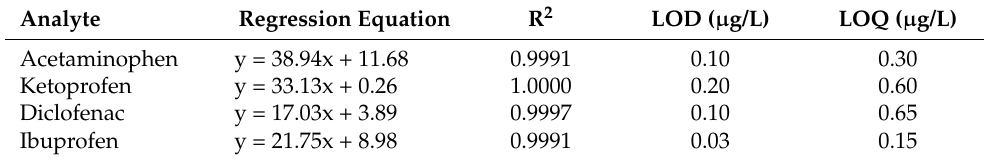
Table 4. Linear regression